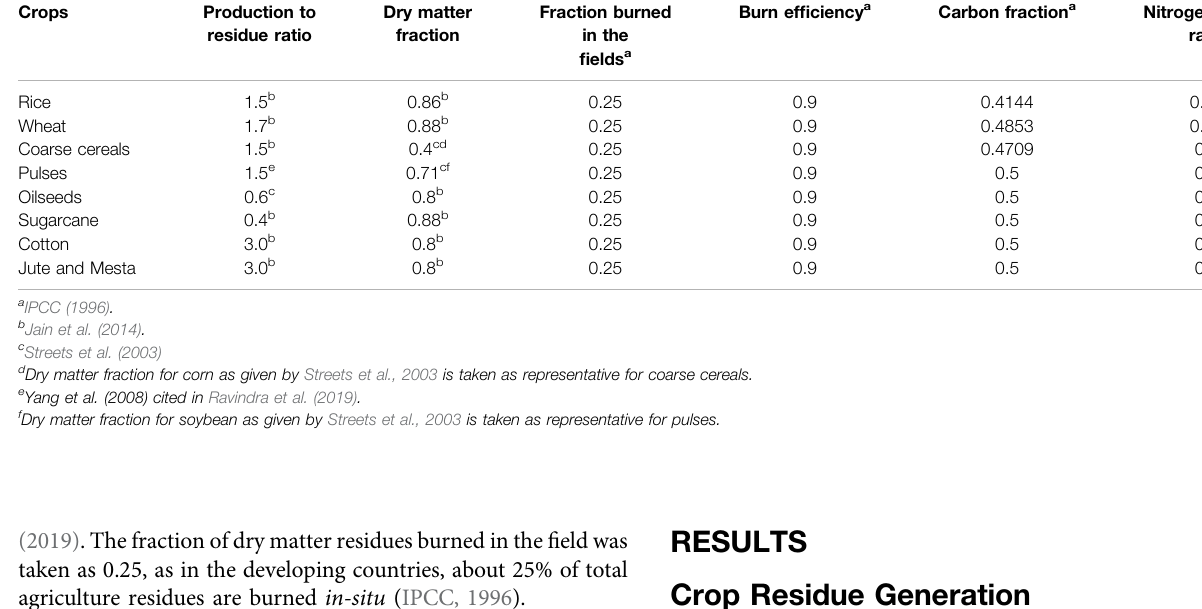
TABLE 1 | Coef fi cients used in the estimation of crop residue burning.